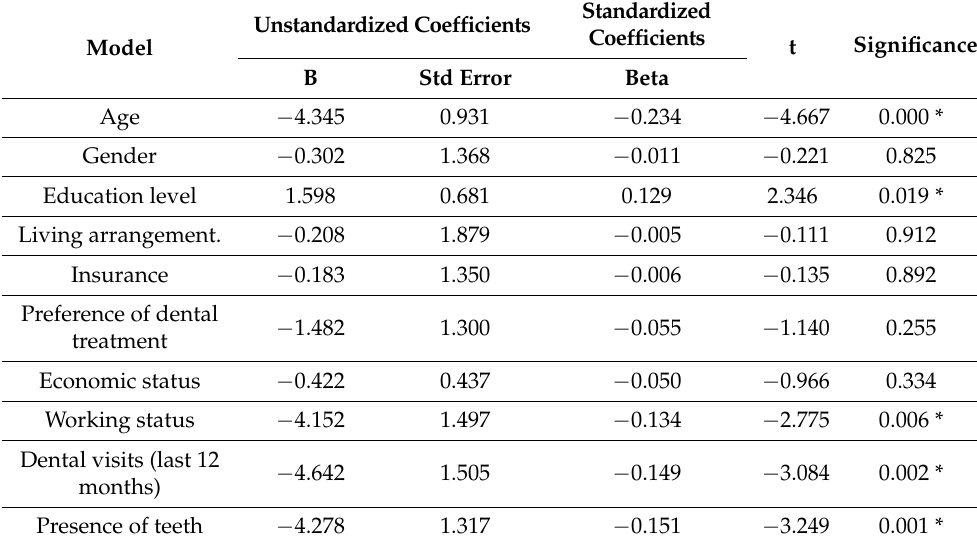
Table 7. Multiple regression analysis for the association between GSEOH scores and the study’s independent variable.